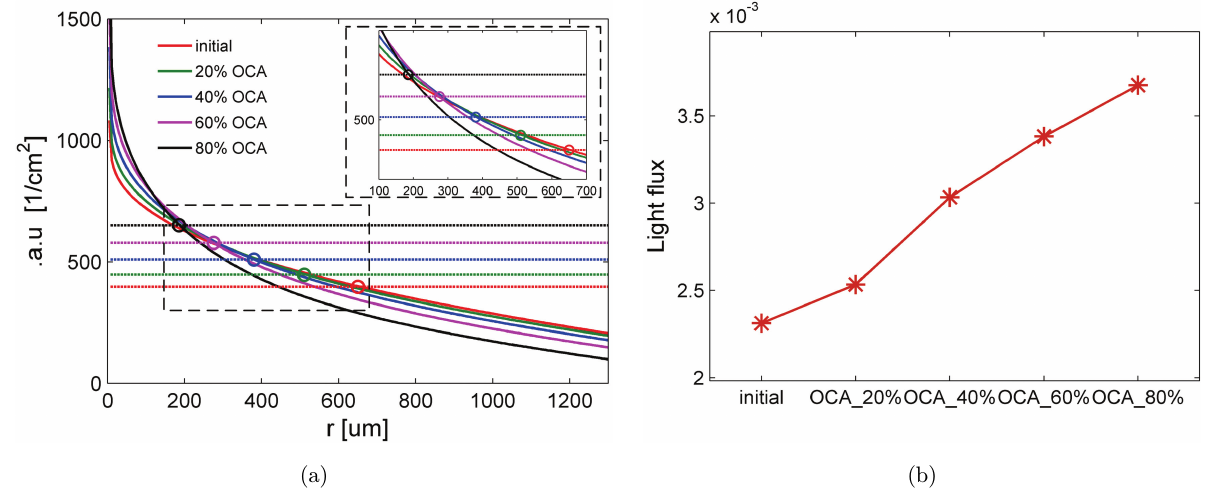
Fig. 4. Improvement of light distribution in skin by optical clearing e®ect. (a) Change of radial distribution and (b) improvement of light °ux at tattoo layer by skin optical clearing e®ect from 20% to 80%.